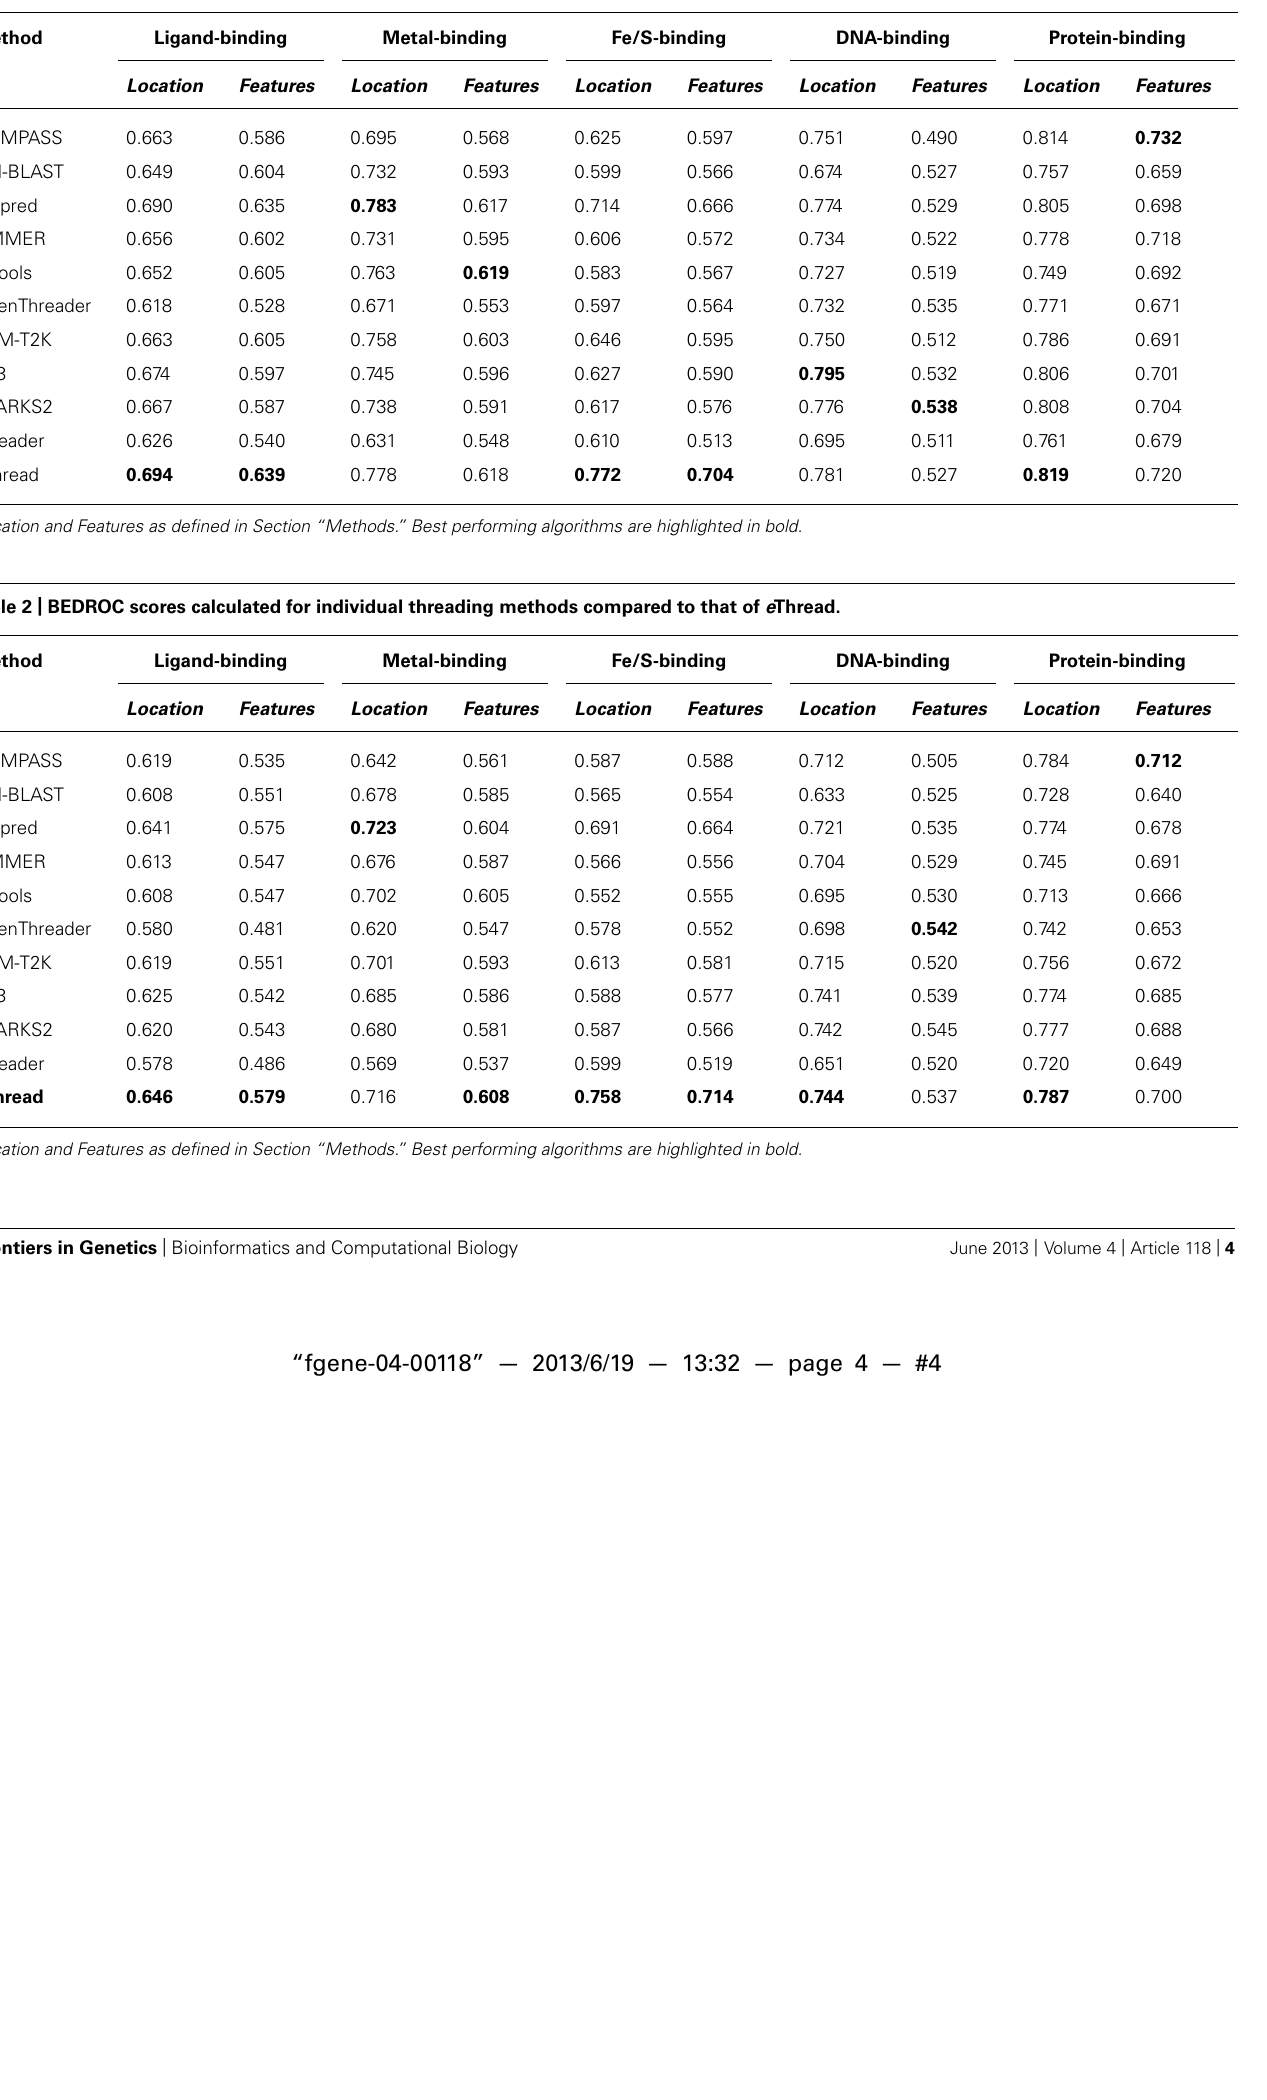
Table 1 |Area under the ROC curve for individual threading methods compared to that of e Thread.